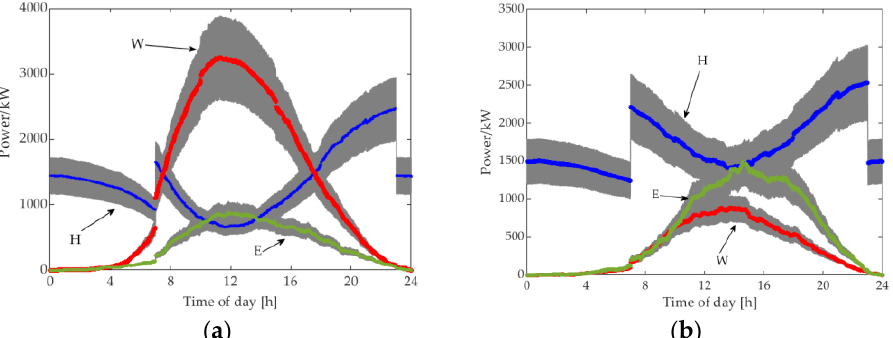
Figure 10. V2G Power demand response distribution of EVA-DR in weekday and weekend ( a ) weekday; ( b ) weekend.